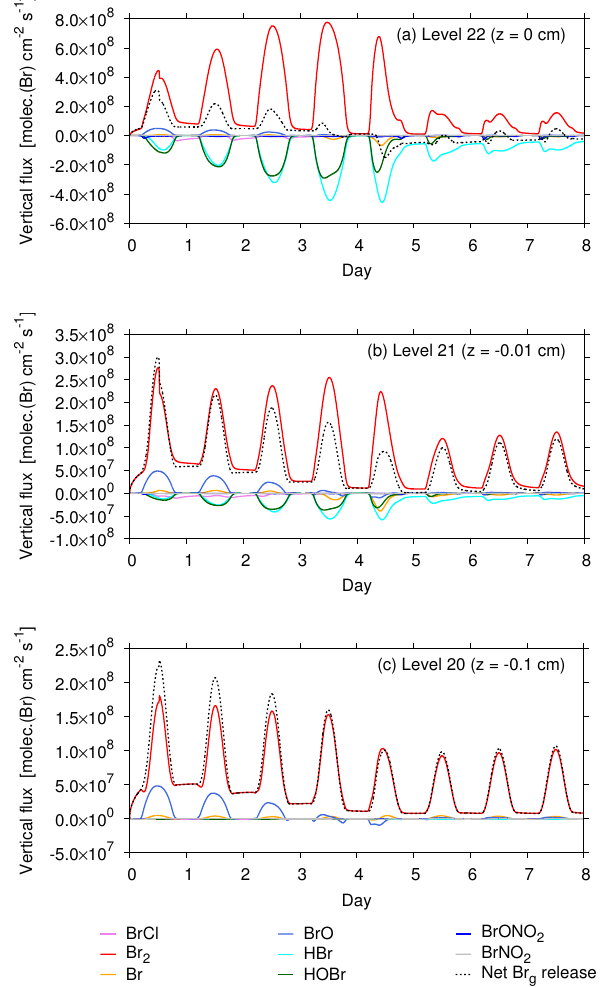
Fig. 7. Vertical fluxes of major inorganic bromine species in the top 1 mm of the snowpack as simulated at U 2 = 4.5ms − 1 and N = 0 . 031 s − 1 : (a) z = 0cm (the top of the snowpack), (b) z = − 0 . 01 cm, and (c) z = − 0 . 1 cm.